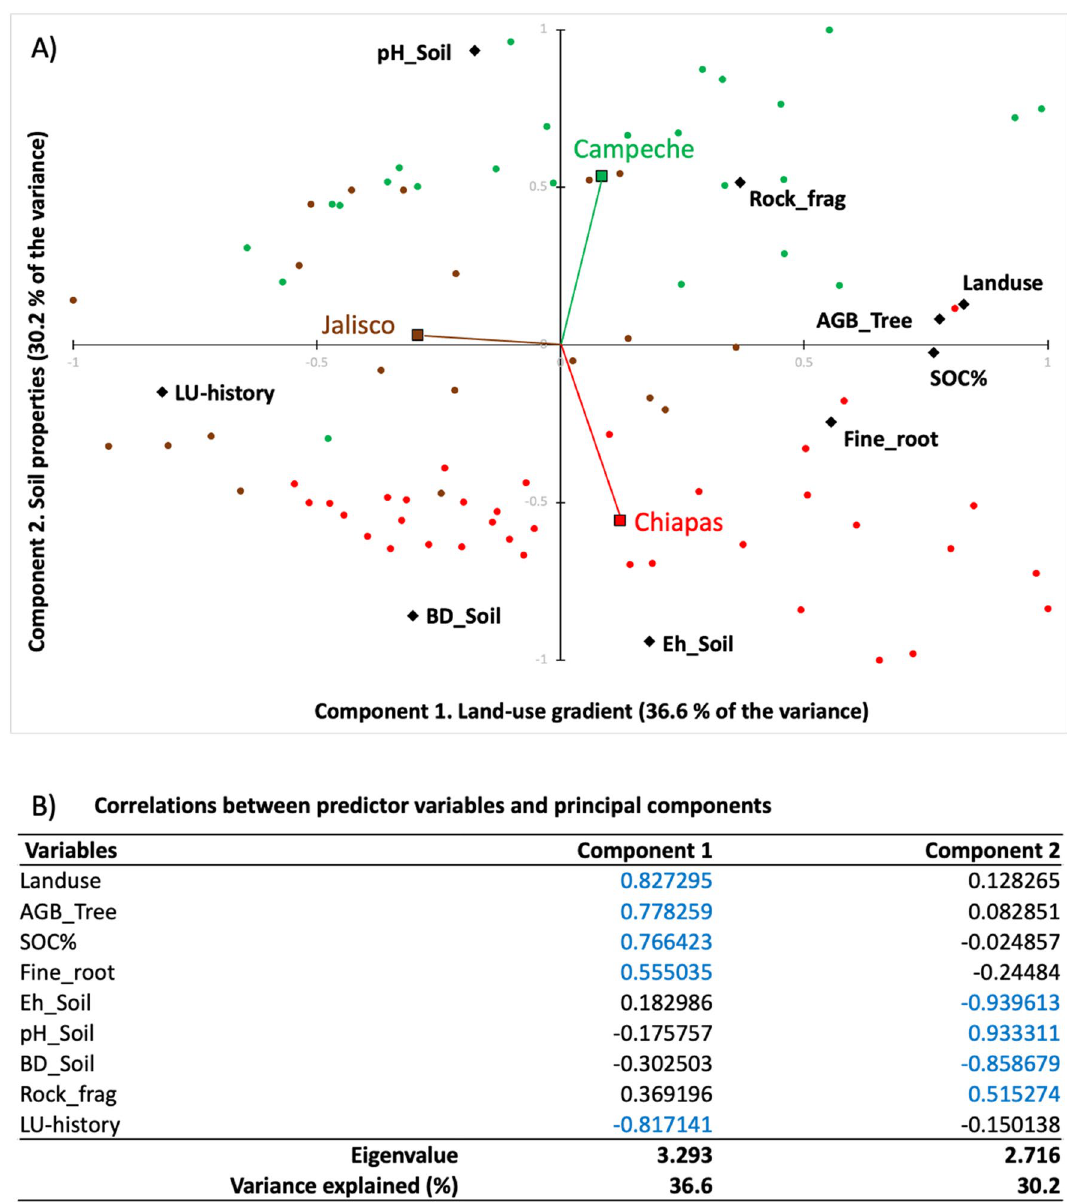
Figure 4. Component plotting of multiple variables including soil organic carbon content (%) based on the principal component analysis (PCA). ( A ) PCA plot with observations; ( B ) Correlations between principal components and predictor variables. AGB = aboveground biomass, LU = land use, BD = soil bulk density (g cm −3 ), Eh = soil oxidation–reduction potential (ORP, mV), SOC = soil organic carbon concentrations